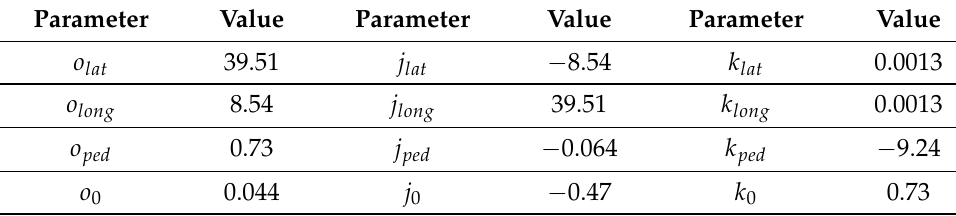
Table 2. Rotor aerodynamics parameters